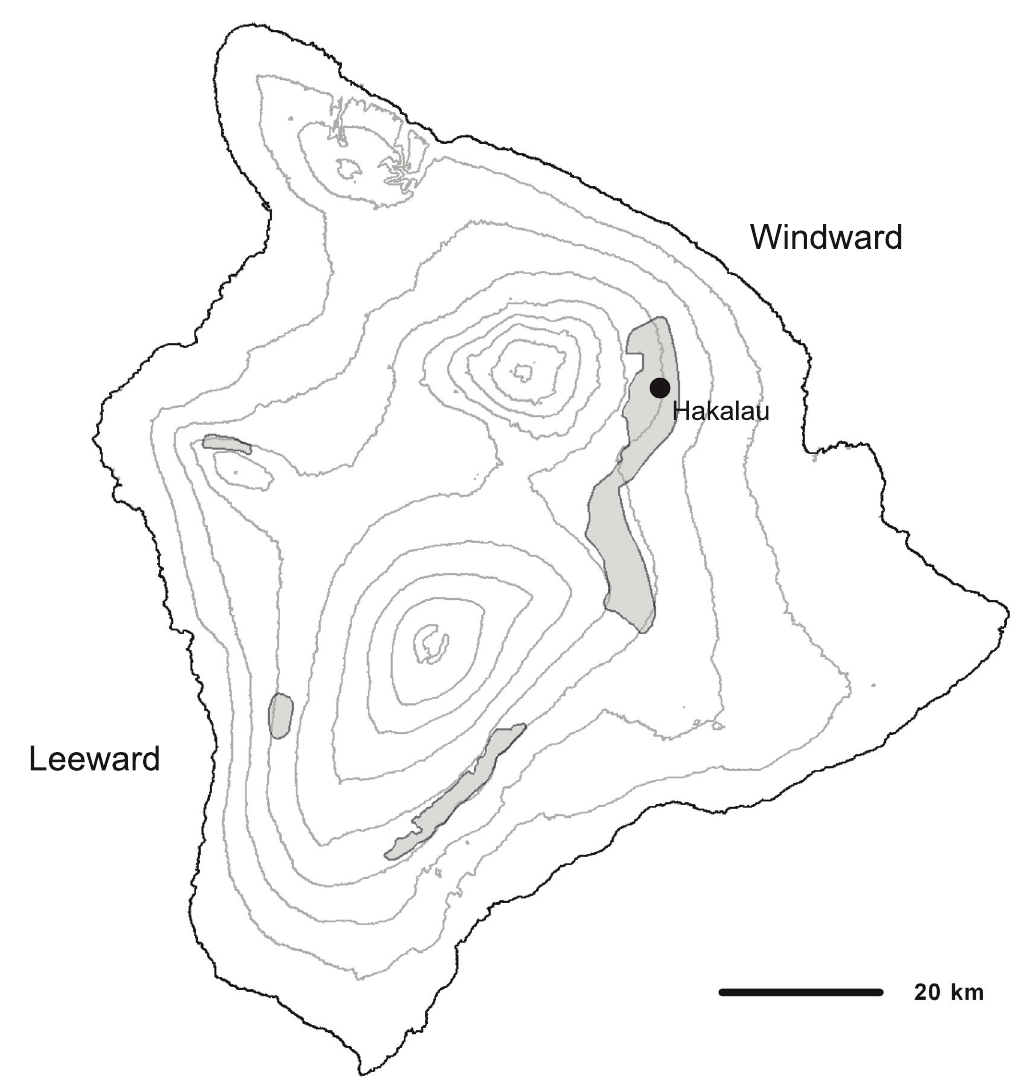
Fig 1. Estimated range of the Hawai‘i Creeper (gray shaded areas) and approximate location of Hakalau on Hawai‘i (courtesy of M. Goressen, HCSU, University of Hawai‘i at Hilo).